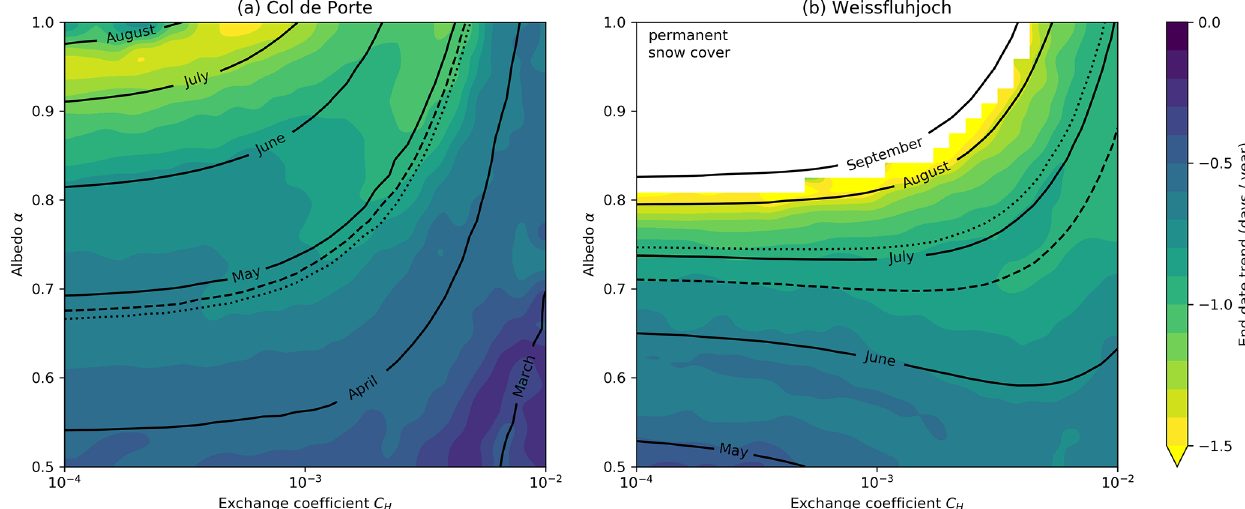
Figure 5. Averages (solid contours) and trends (colours) for continuous snow cover end dates in 2PM simulations at (a) Col de Porte and (b) Weissfluhjoch, excluding simulations with permanent snow cover. Dotted lines are contours for average observed snow cover end dates, and dashed lines are dates of maximum warming trends in the driving data (Fig.